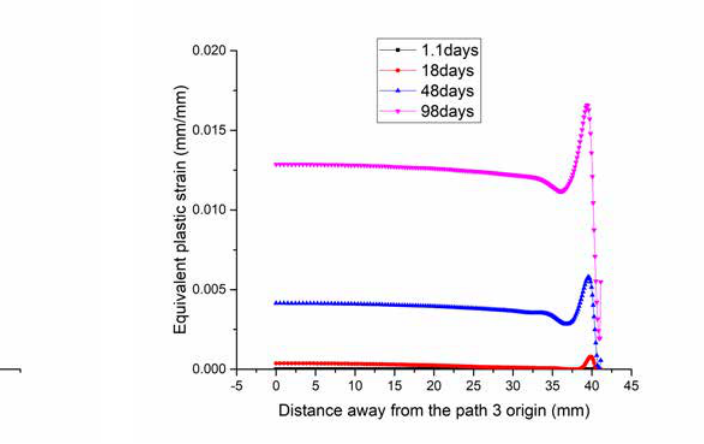
Figure 17: The evolution of equivalent plastic strains along Path